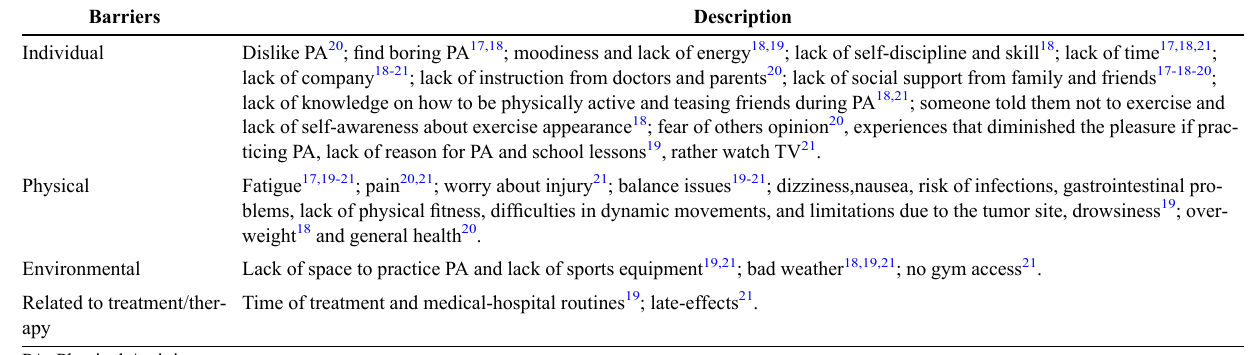
Table 3 - Synthesis of barriers to PA in pediatric cancer patients and